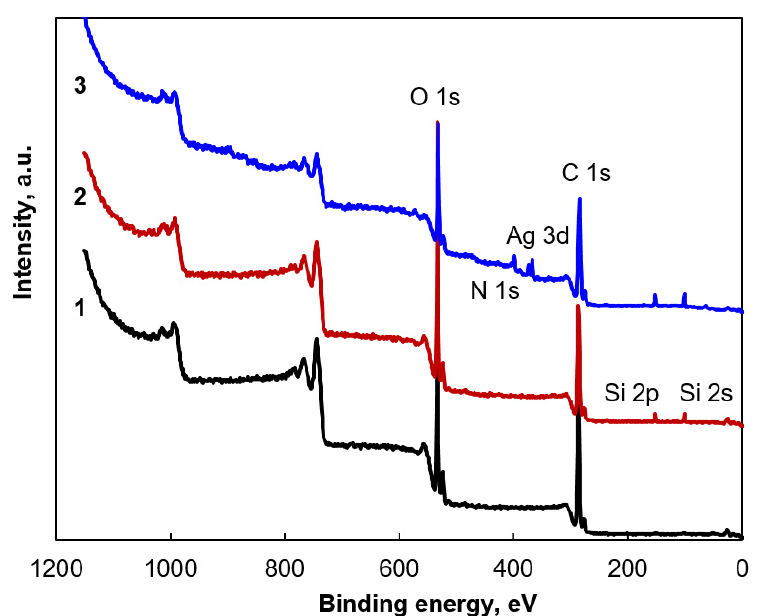
Figure 6. XPS low-resolution survey spectra of untreated CF ( curve 1 ), silylated CF ( curve 2 ), and silylated CF–Ag nanohybrid ( curve 3